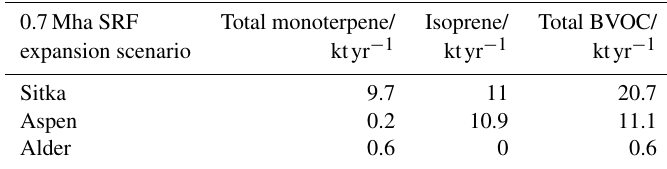
Table 7. Modelled mean annual emissions from 0.7Mha of SRF expansion.